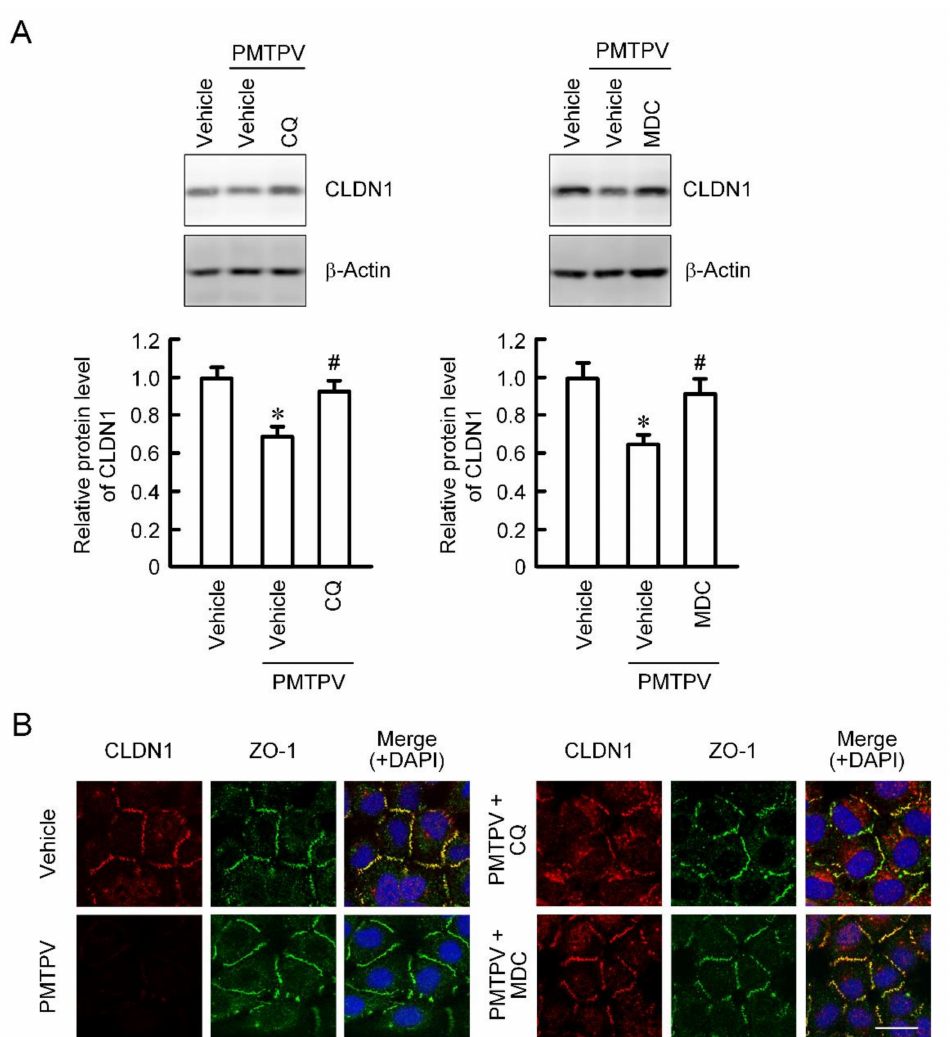
Figure 3. Inhibition of PMTPV-induced decrease in CLDN1 expression by endocytosis and lysosome inhibitors. A549 cells were incubated with PMTPV at 100 µ M for 24 h in the presence and absence (vehicle) of 10 µ M chloroquine (CQ) or 5 µ M monodansylcadaverine (MDC). ( A ) The cell lysates were immunoblotted with anti-CLDN1 and anti- β -actin antibodies. The protein level of CLDN1 is represented relative to the values in vehicle. ( B ) The cells were stained with anti-CLDN1 (red), anti-ZO-1 (green) antibodies. Merged images with 4 (cid:48) ,6-diamidino-2-phenylindole (DAPI) (blue) are indicated on the right. Scale bar represents 10 µ m. n = 3–4. * p < 0.05 compared with vehicle. # p < 0.05 compared with PMTPV